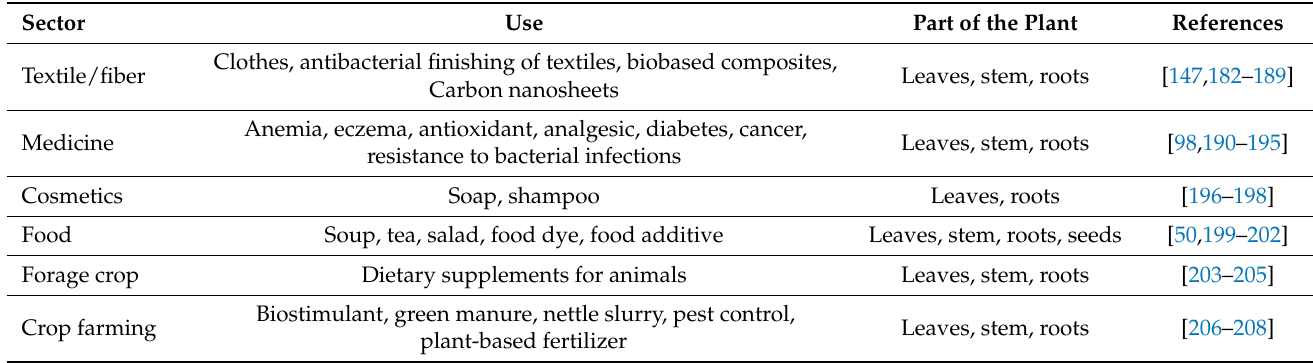
Table 3. Potential end products made from Urtica dioica